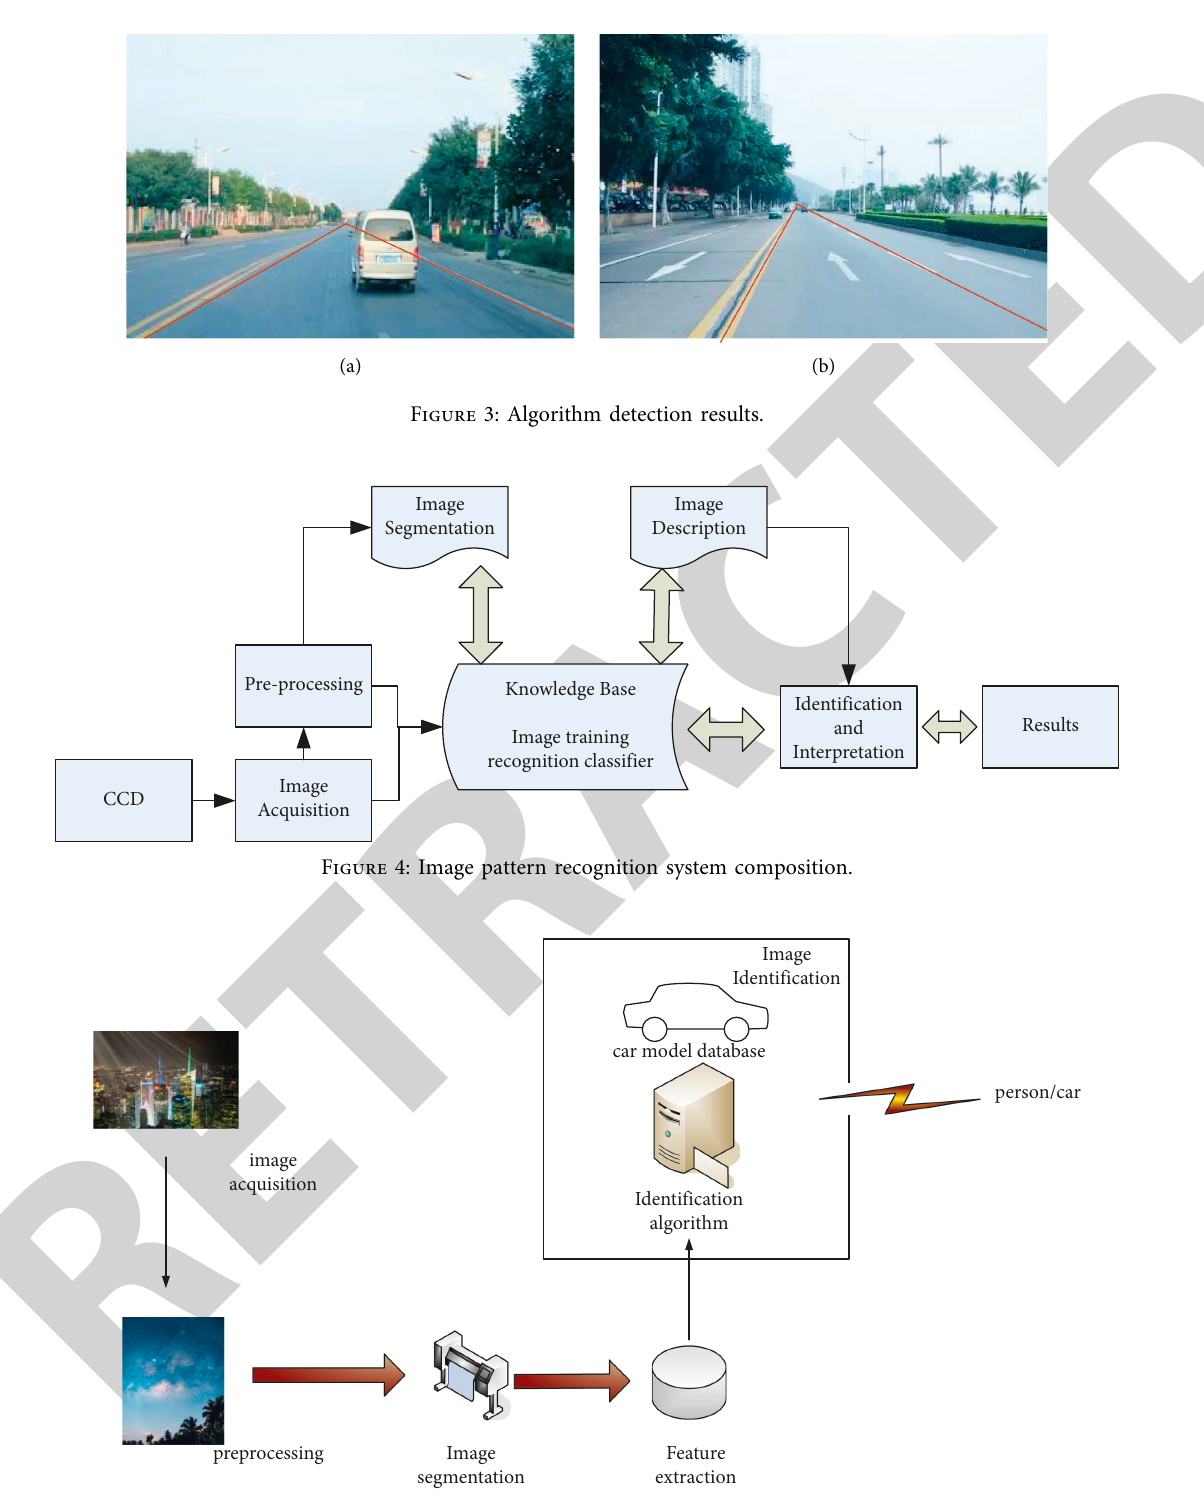
Figure 5: Image recognition training classifier.